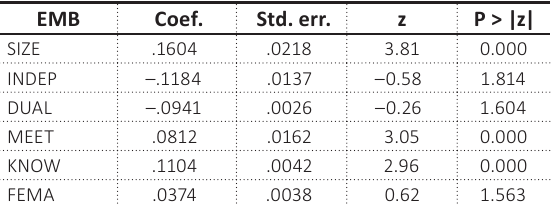
Table 3. Regression of feasible generalized least squares